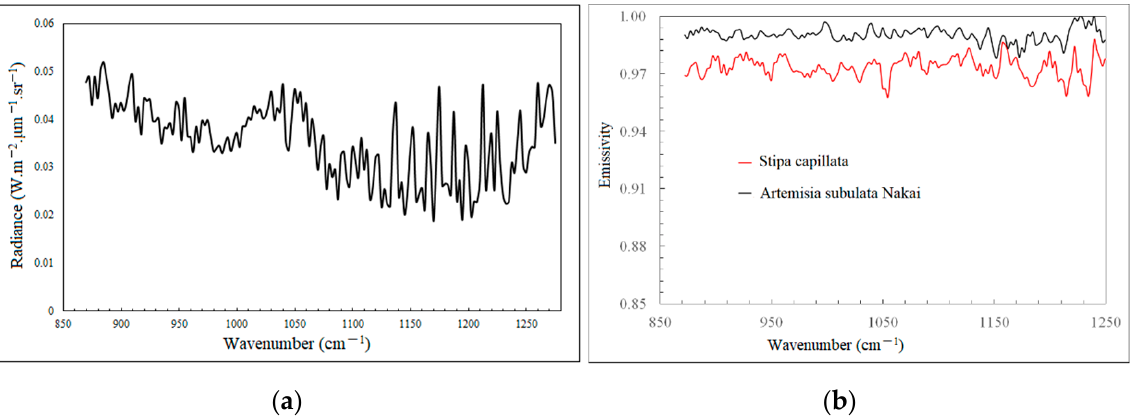
Figure 15. Temperature of Artemisia subulata Nakai retrieved from thee HTIR dataset.